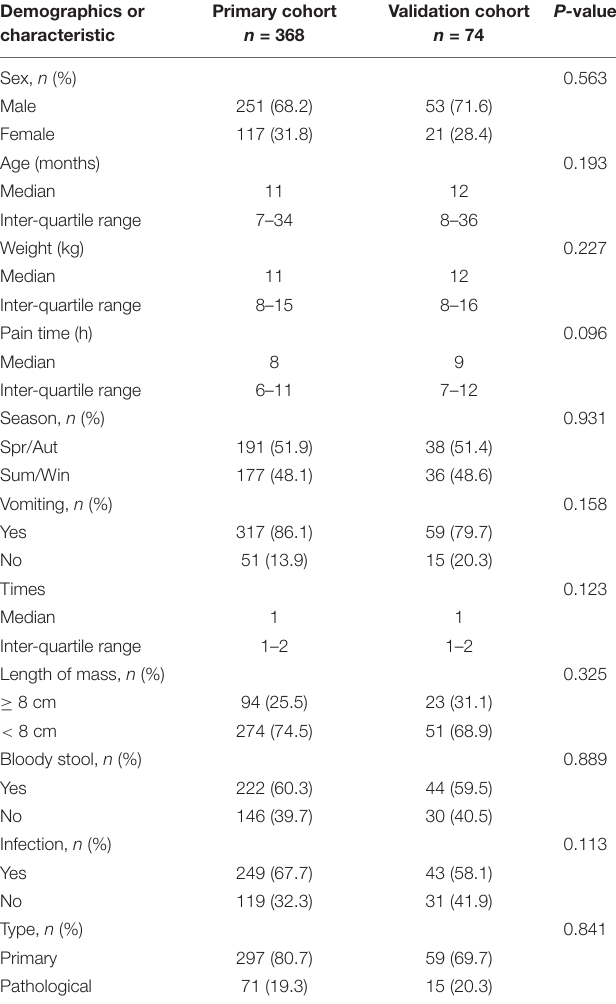
TABLE 1 | Demographics and clinicopathologic characteristics of children with